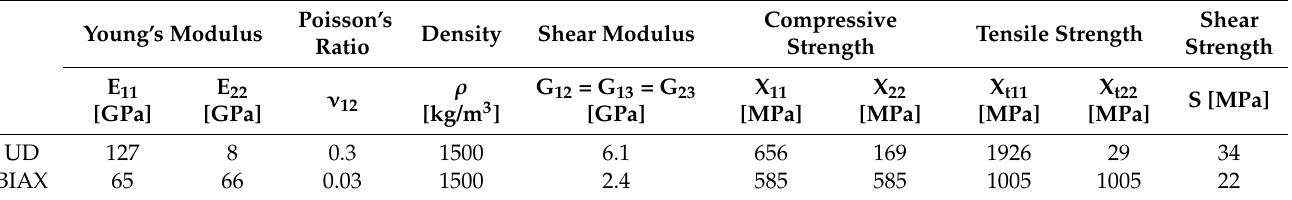
Table 2. Foam core material properties [23].